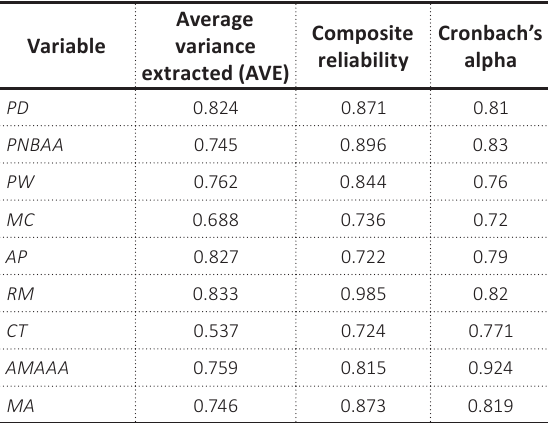
Table 3. Convergent reliability and